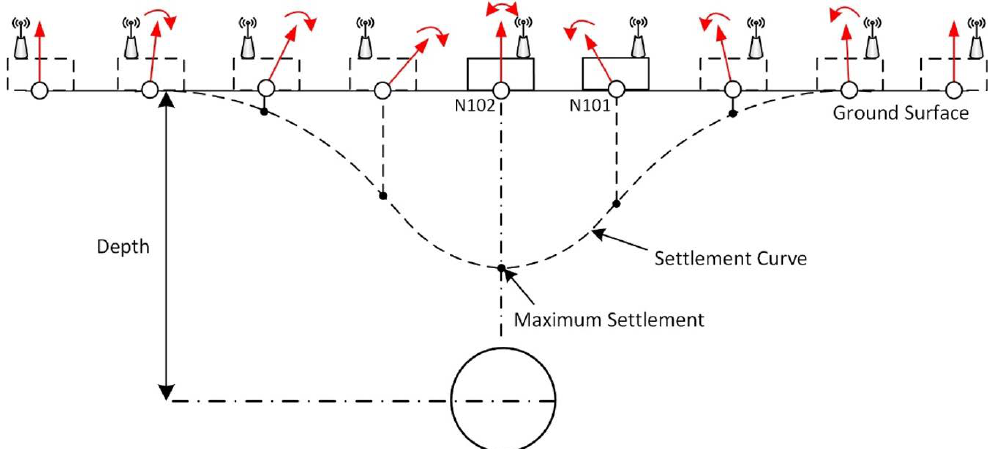
Figure 13. Planned Distribution of Sensor Nodes along the Transversal Direction and Drawing of a Settlement Curve. The settlement is gradually accumulated from the node deployed at a distance showing no variations to the one at the excavating center on the ground. Starting with a value of zero, a smooth curve of vertical ground settlement can be obtained using the tangent function and